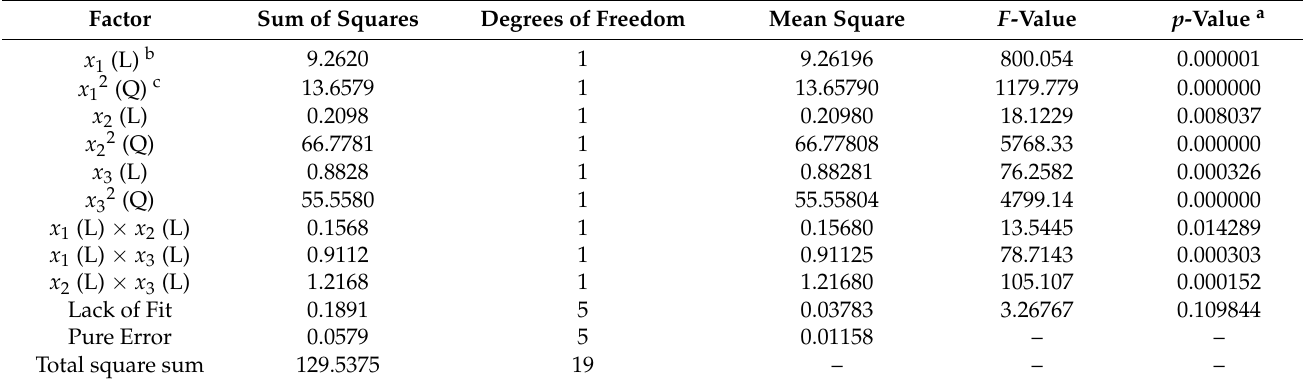
Table 3. Results of the analysis of variance applied to the quadratic polynomial model describing the influence of independent variables on the surface